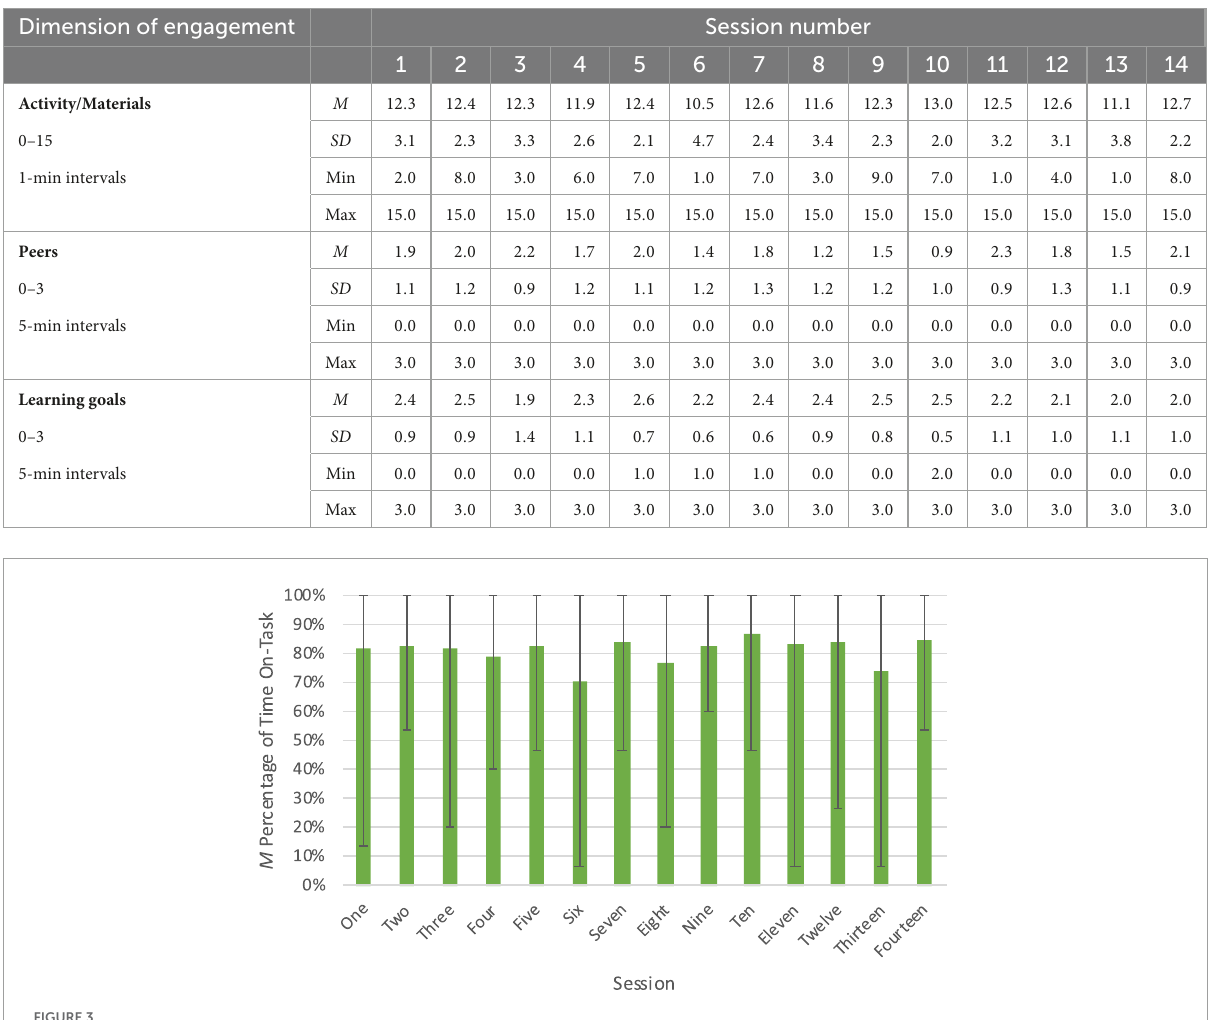
FIGURE3 Engagement with the activity/materials across sessions of the Block Play Intervention. Figure shows percentage of engagement out of total coded time (15 min) with the activity/materials at each session. The range from minimum to maximum engagement is represented by error